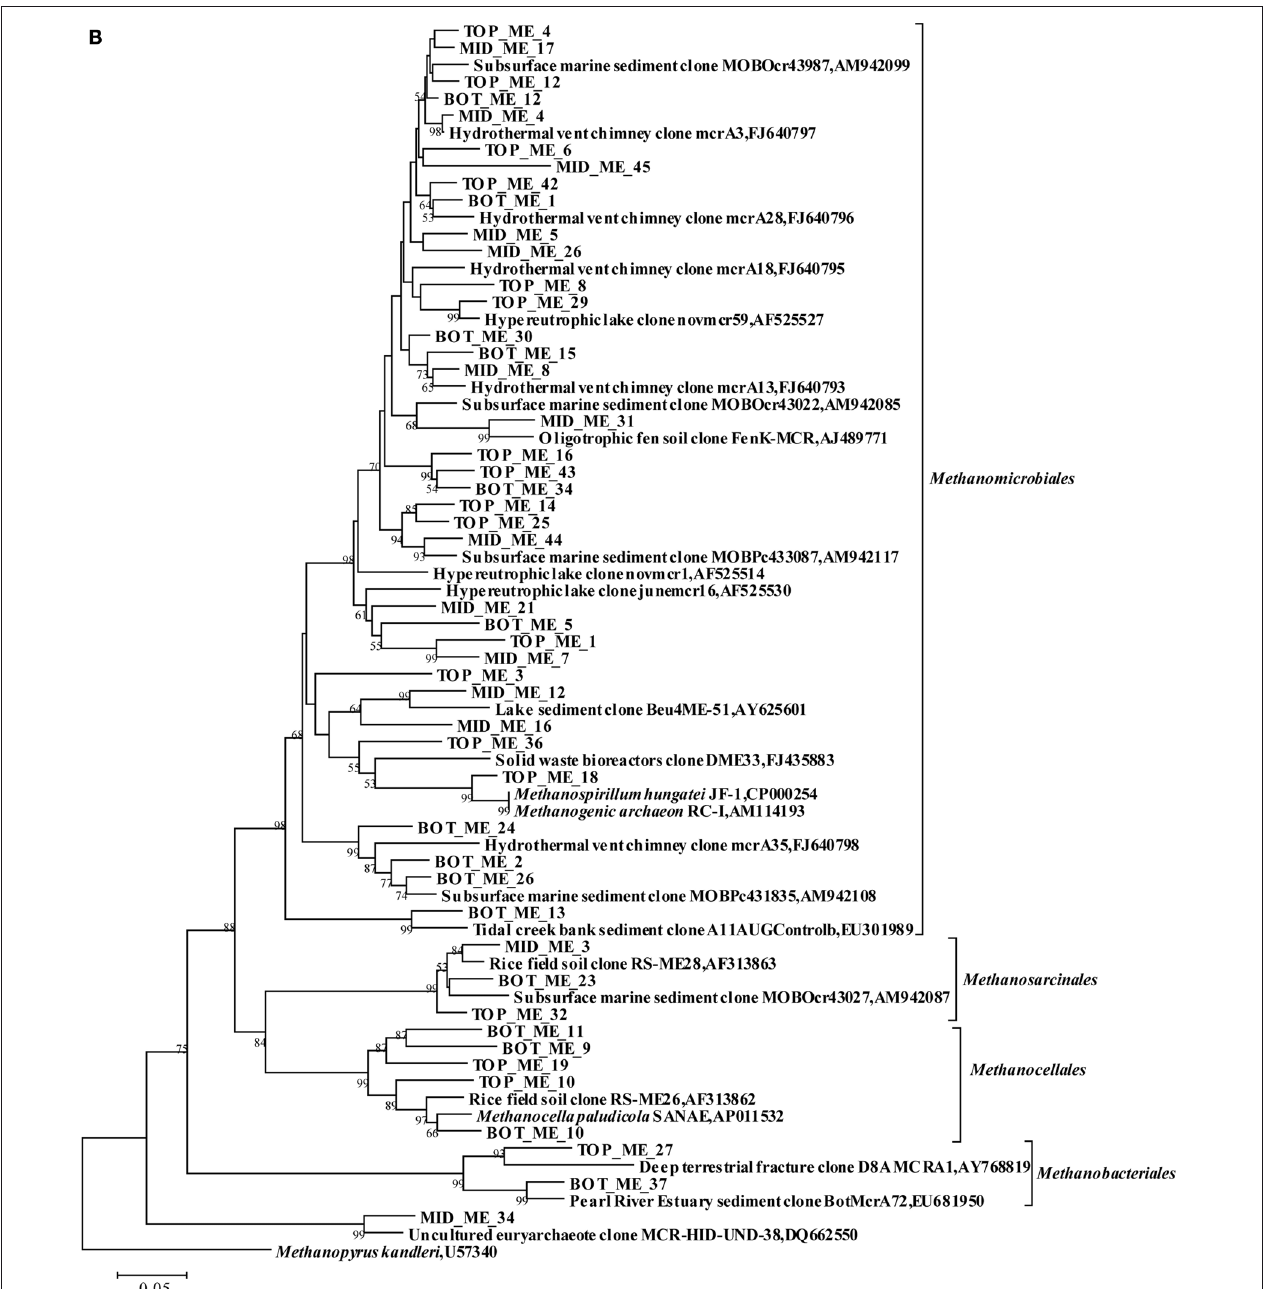
FIGURE 3 | Phylogenetic trees showing the affiliations of euryarchaeal RT-PCR products of 16S rRNA sequences (A) and mcrA gene sequences (B) retrieved from this study with selected reference sequences, respectively. The clones from the top, middle and bottom layers are differentiated as TOP, MID, and BOT, respectively. The trees were constructed by neighbor-joining, using nearly full-length aligned nucleotides sequences